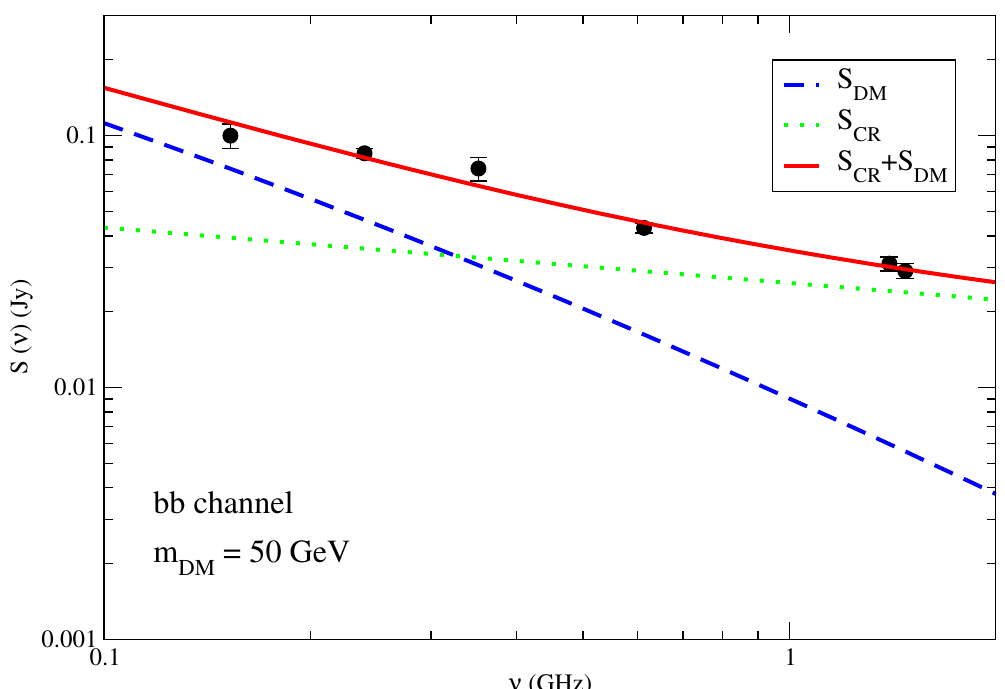
Figure 2. The best-fit dark matter scenario for the central Ophiuchus cluster radio data ( m DM = 50 GeV via the b ¯ b channel) [37]. The red solid line, green dotted line, and blue dashed line represent the total predicted radio flux S ( ν ) , the cosmic-ray contribution (power-law form), and the dark matter contribution, respectively. The data with error bars were extracted from [95].